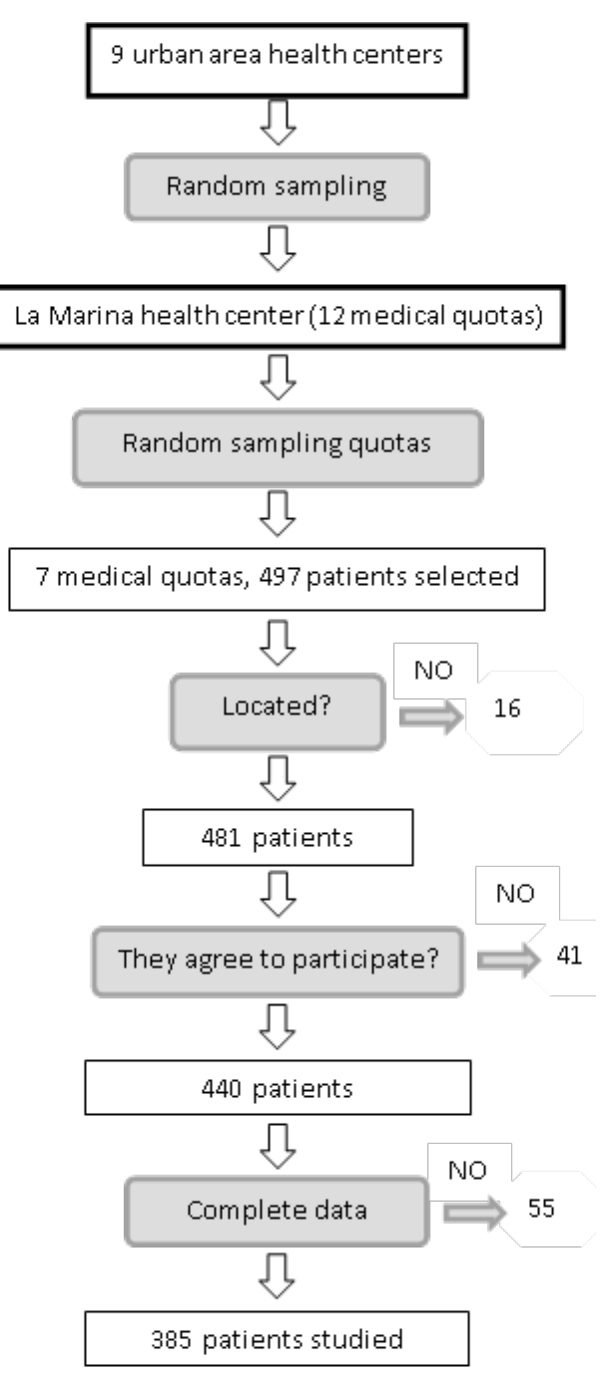
Figure 1. Selection process for patients included in the sample.